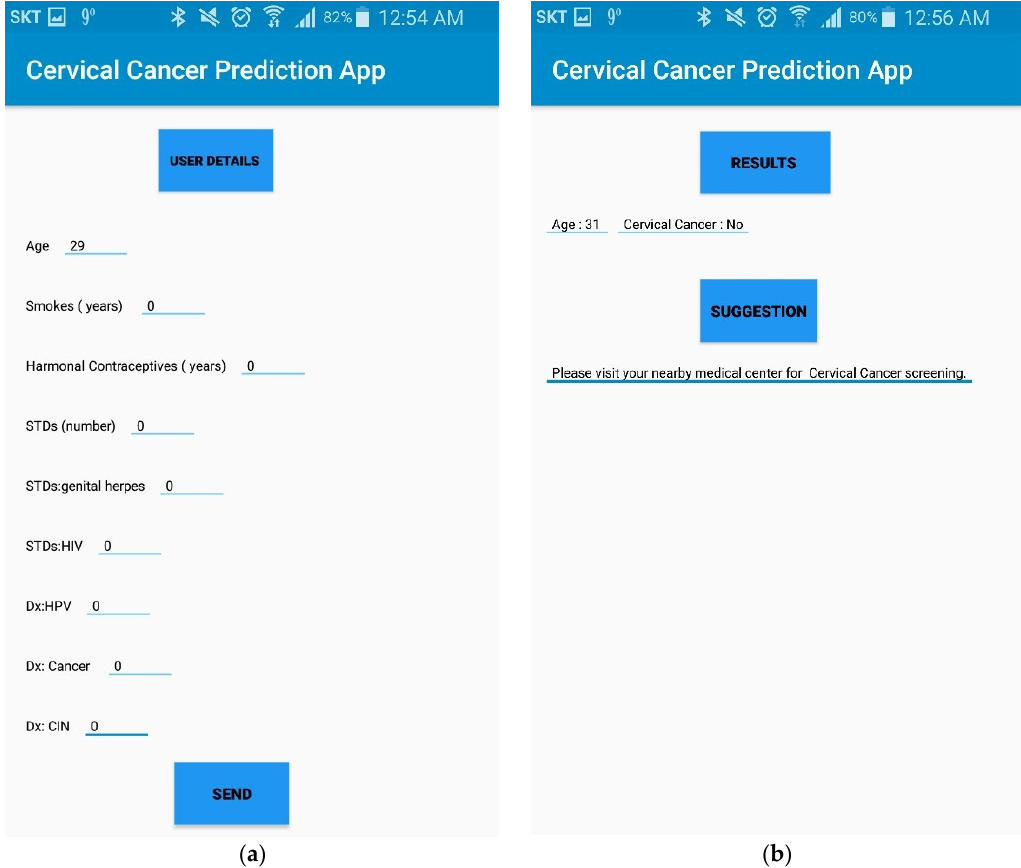
Figure 4. ( a ) Interface of mobile application to gather user’s data. ( b ) Prediction result interface of CCPM mobile application.